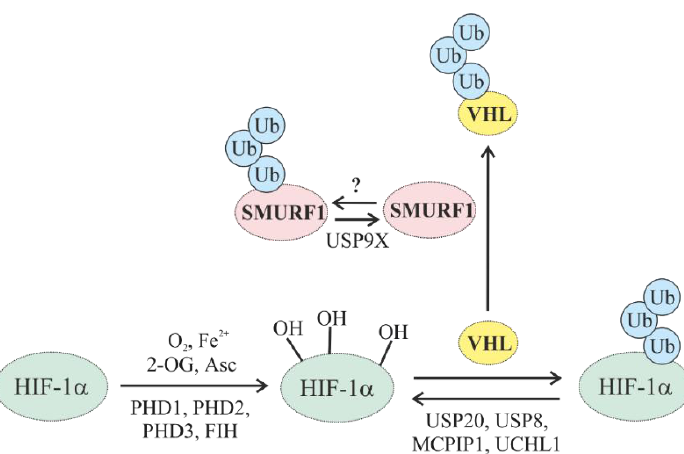
Figure 5. Involvement of E3 ligases and DUBs in the oxygen-dependent regulation of HIF. HIF-α subunits are hydroxylated in an O 2 -, Fe 2 + -, 2-oxoglutarate (2-OG)-, and ascorbate-dependent reaction. Hydroxylated HIF-α subunits are then recognized by von Hippel-Lindau (VHL), ubiquitylated, and degraded by the proteasome. VHL itself can be degraded by the E3 ligase SMURF1 (SMAD ubiquitination regulatory factor-1), which can be opposed by USP9X. VHL-mediated ubiquitylation can be antagonized by the DUBs USP20, USP8, MCPIP1, and UCHL1. E3 ligases are depicted in bold.